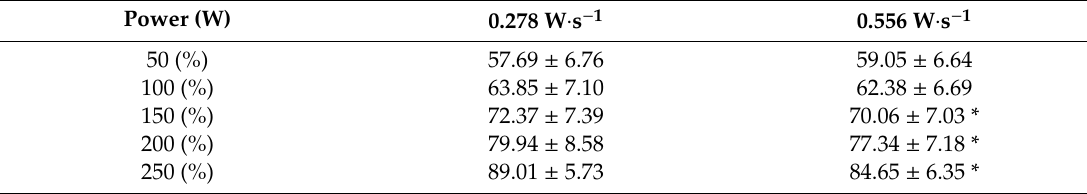
Table 3. Percentage of maximal heart rate in submaximal intensities (50–250 W) (x ± SD). Power